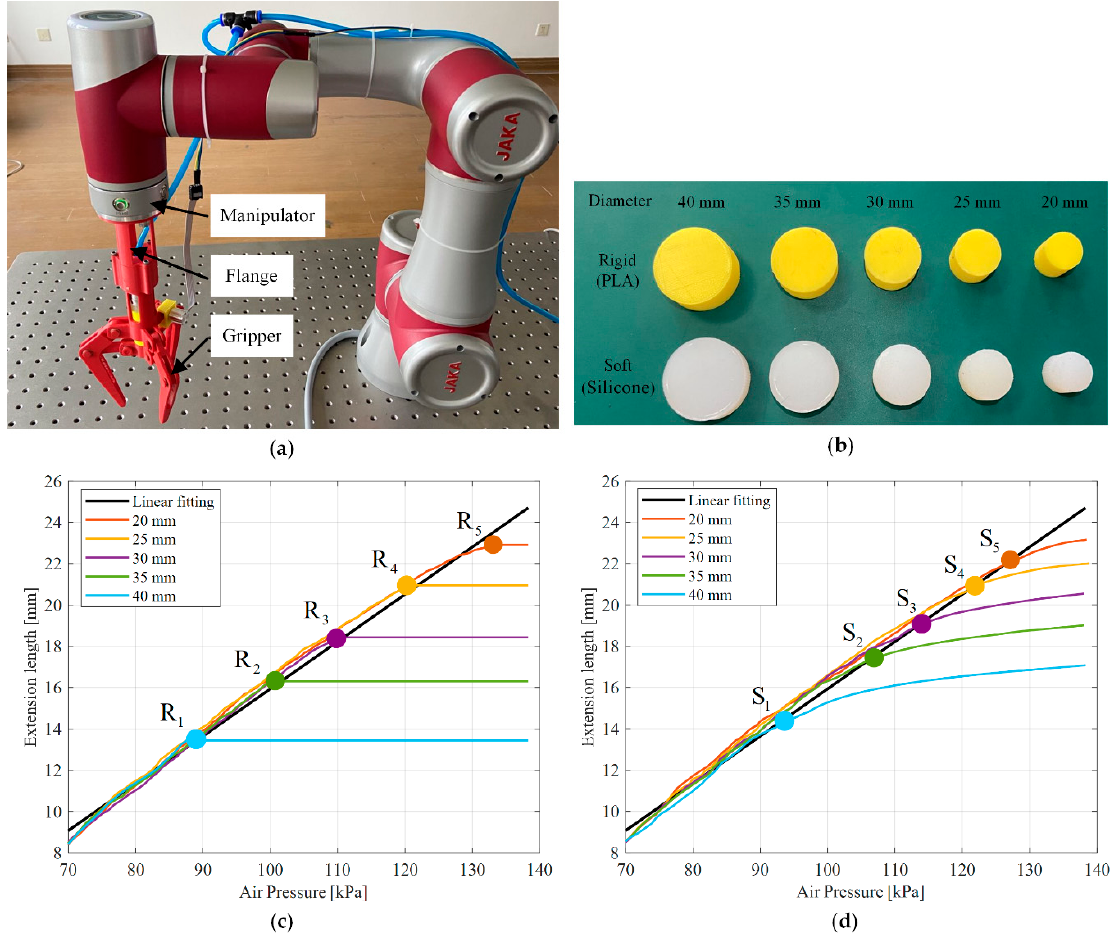
Figure 8. Contact state estimation of the gripper during validation test: ( a ) fixed gripper on the end of manipulator; ( b ) rigid and soft cylindrical objects; ( c ) relationship between pressure and extension length of the gripper gripping rigid cylinders; ( d ) relationship between pressure and extension length of the gripper gripping soft cylinders.